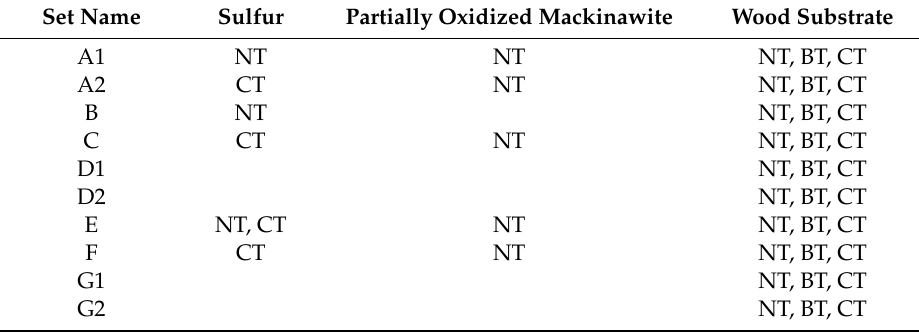
Table 3. Compounds identified by Raman spectroscopy based on the extraction methods.